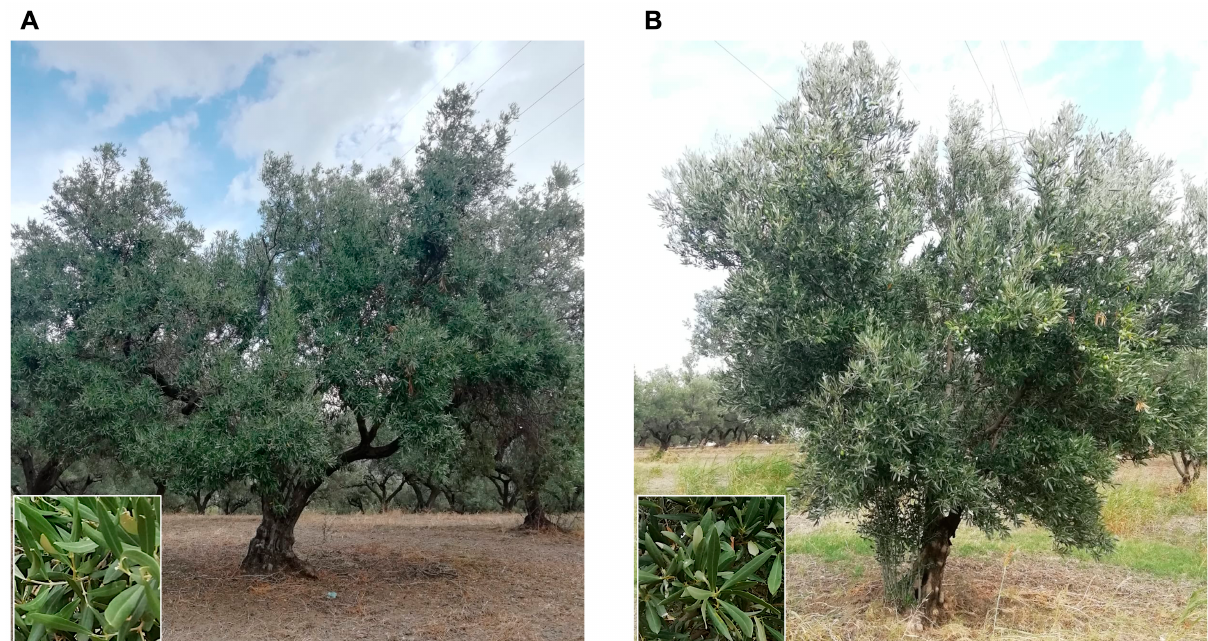
Figure 1 . O. europaea L. Nocellara del Belice cultivar ( A ) and Carolea cultivar ( B ). Figure 1. O. europaea L. Nocellara del Belice cultivar ( A ) and Carolea cultivar ( B